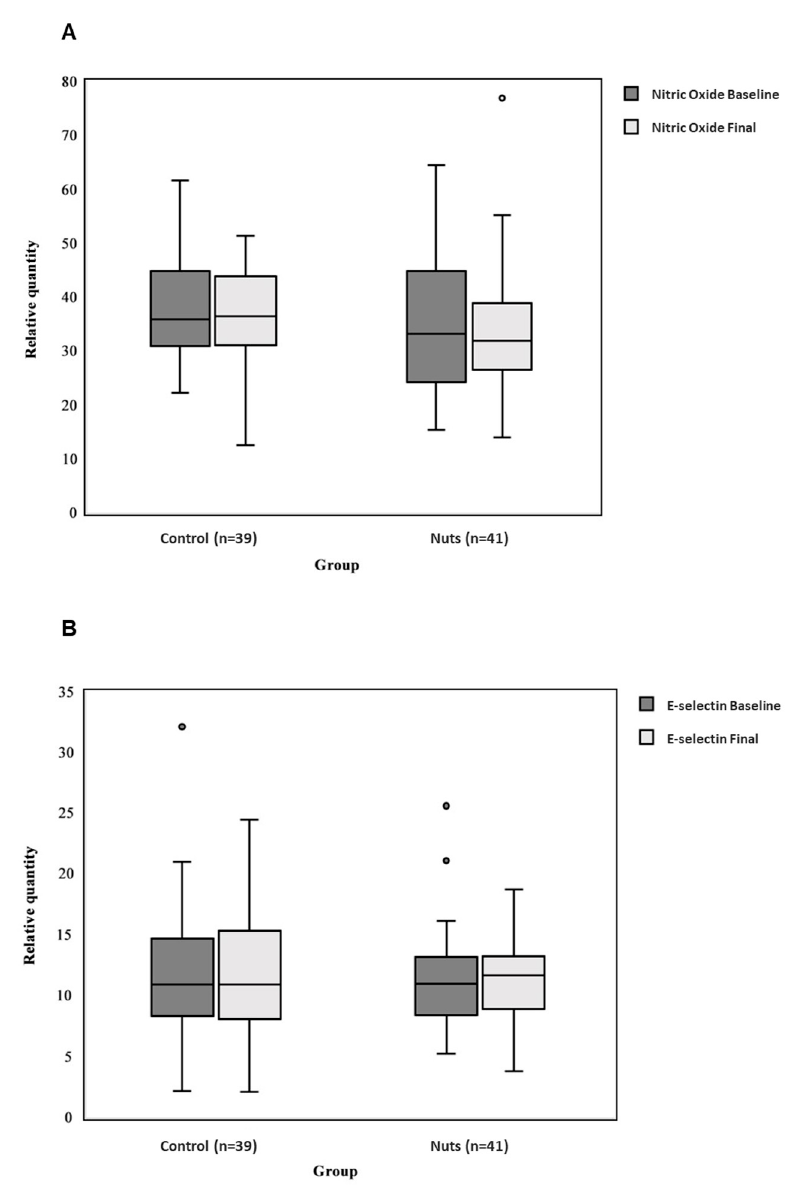
Figure 3. Box plot of the differences between the control group and the nut group in the concentrations of nitric oxide ( A ) and E-selectin ( B ) erectile function markers. ANCOVA models were used to assess differences between intervention groups. Changes were adjusted for baseline values. A horizontal line in the boxplot illustrates the median value. The upper and lower bars indicate the third and first percentiles, respectively. Outliers are plotted as individual circles. In this analysis 3 participants (2 participants in the nut group and 1 in the control group) had missing values for NO or E-selectin (see Figure 1).